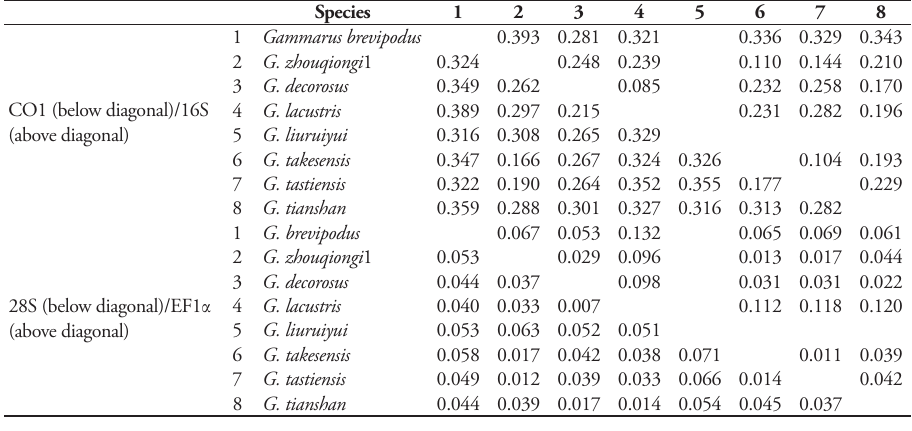
Table 3. Kimura 2-parameter pairwise genetic distances of Gammarus in